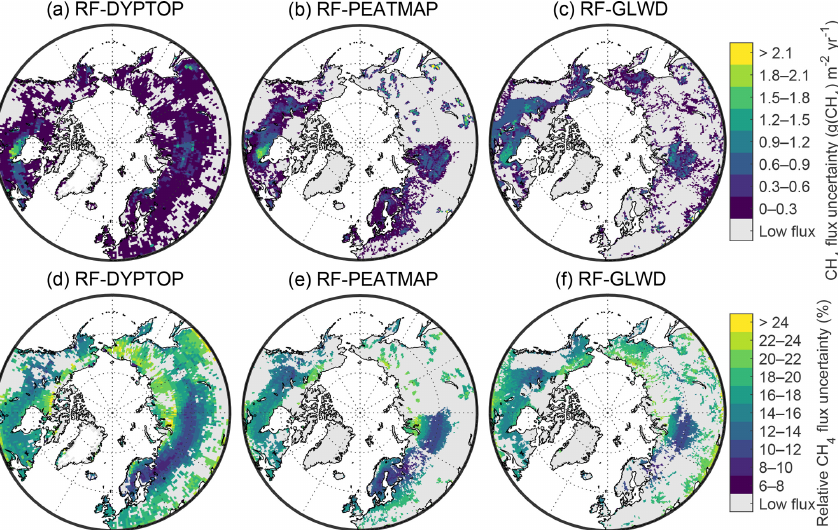
Figure 9. Absolute (a–c) and relative (d–f) uncertainties of the upscaled CH 4 fluxes using different wetland maps. Uncertainty is estimated as 1 σ variability of the predictions by 200 RF models developed by bootstrapping the training data (Sect. 2.1.2). Grid cells with low CH 4